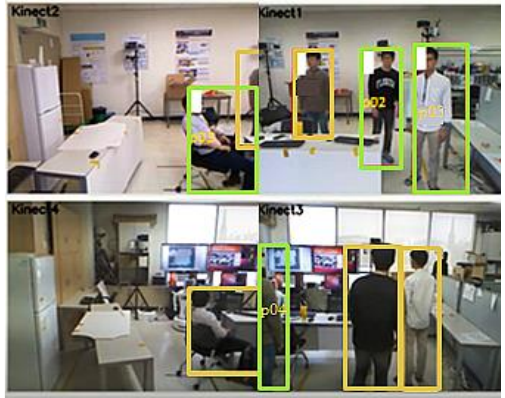
Fig. 8: WHERE fusion keeps correctly 4 detected hu- mans (green ROI rectangular) from total 9 de- tected humans in four Kinects with parallel and orthogonal con(cid:28)gurations